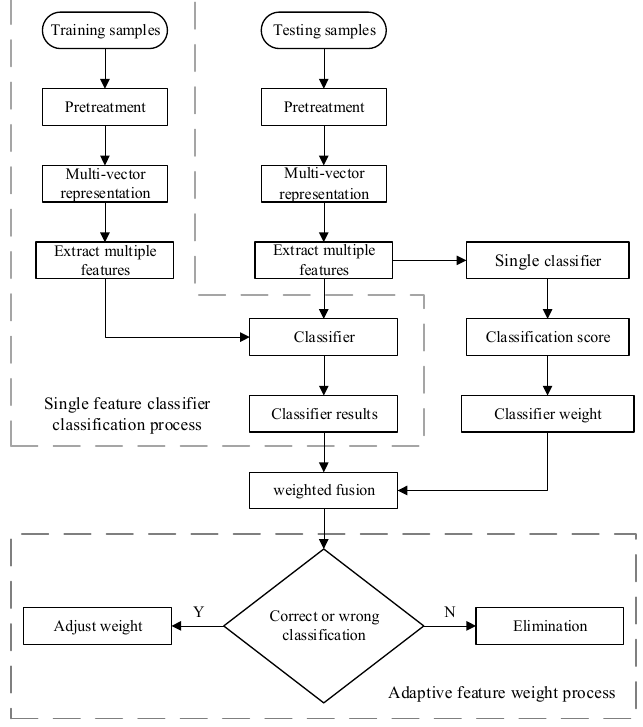
Figure 1. Flowchart of the proposed method.